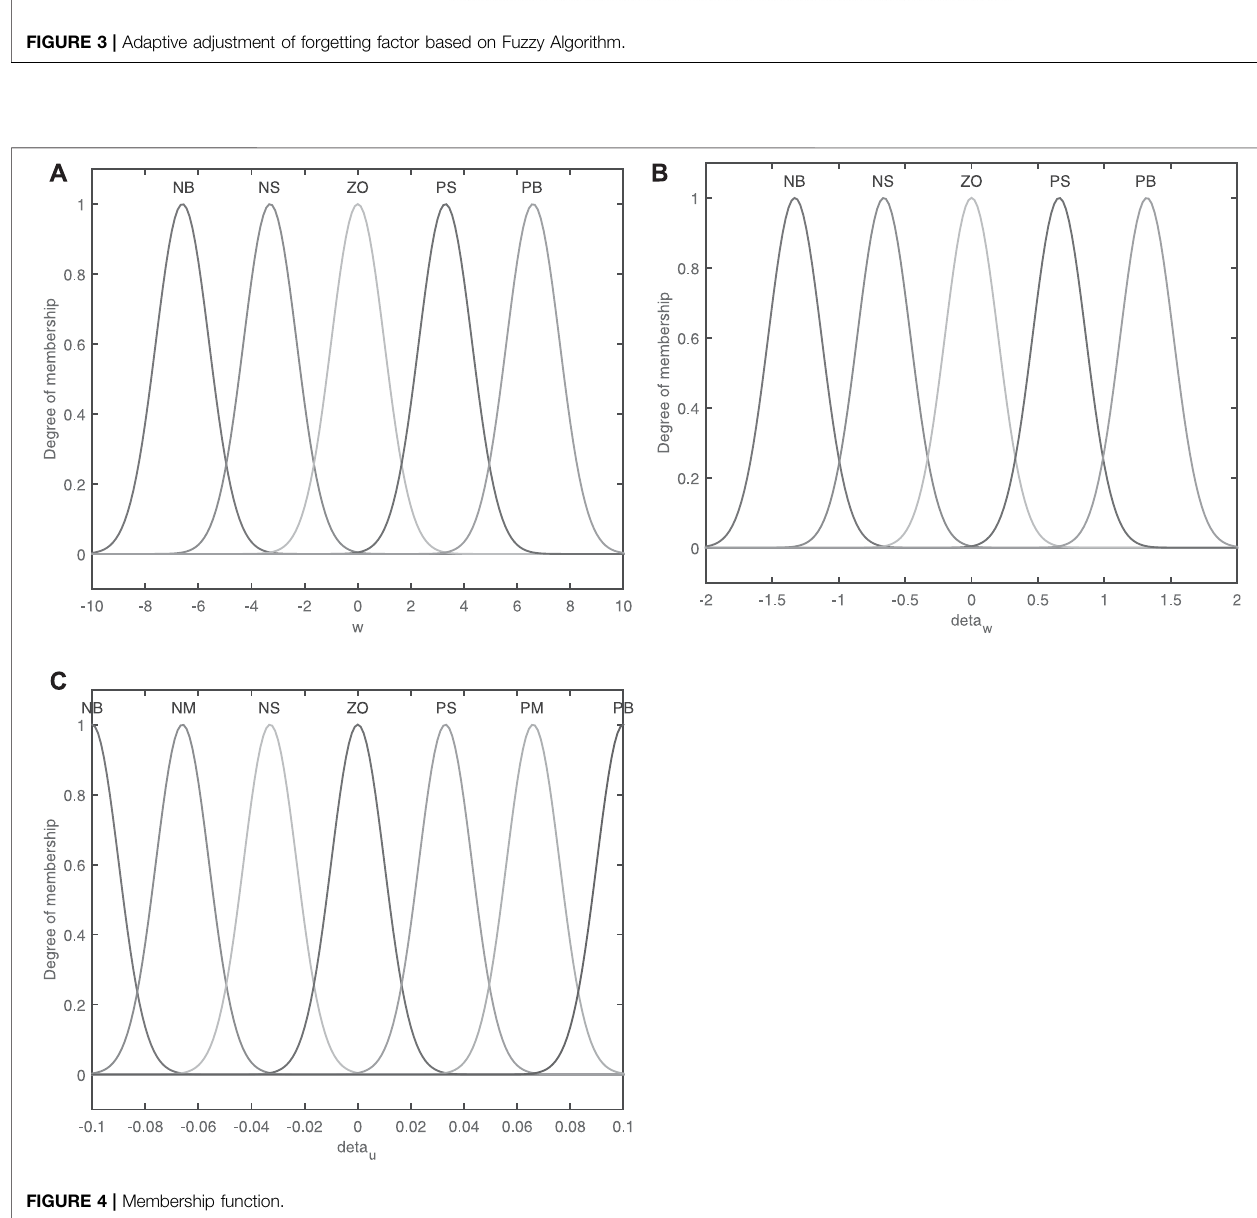
FIGURE 4 | Membership